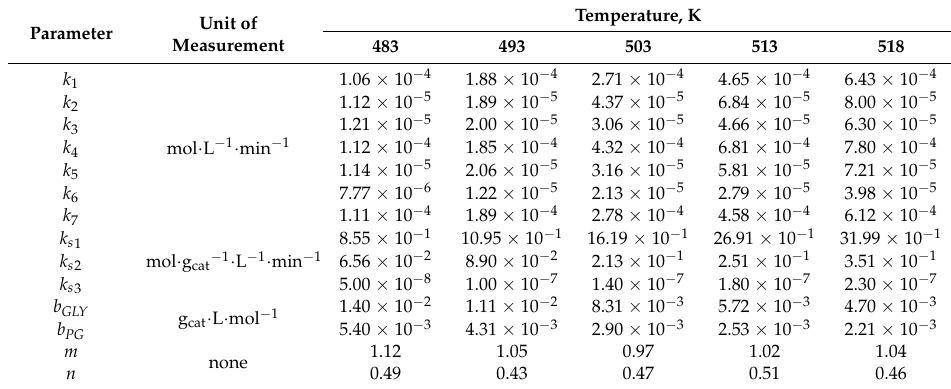
Table 6. The calculated reaction rate constants, adsorption constants and concentration exponents for LA and